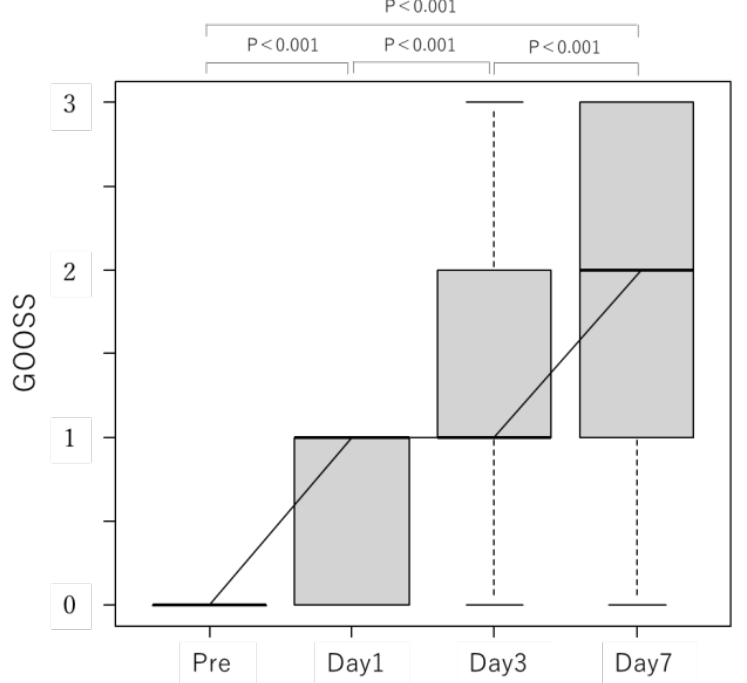
Figure 2. Transition of GOOSS scores up to 1 week after duodenal stent placement. The GOOSS scores prior to and at 1, 3, and 7 days after duodenal stenting were compared; these scores showed improvement after stenting. Comparisons among three or more corresponding groups (Friedman test, p < 0.001) showed significant differences, and Bonferroni’s multiple comparison test also showed significant differences in each group.